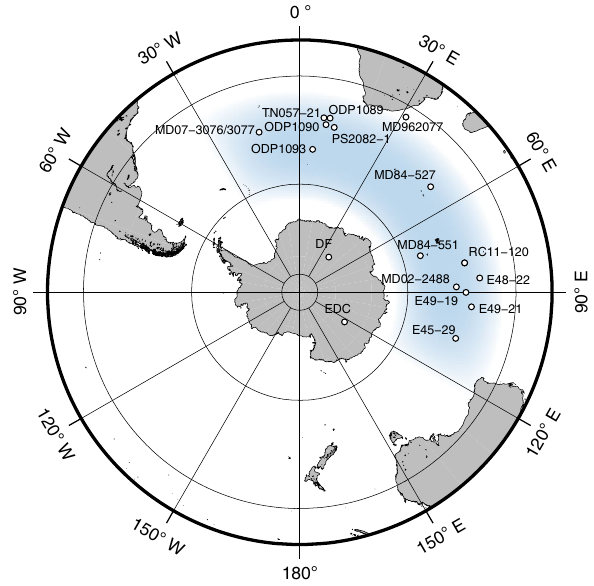
Fig. 1 Locations of ice cores and marine sediment cores. Blue shading indicates the main present-day moisture source of the Dome Fuji site, as determined using back-trajectory calculations 24 – 26 . White dots indicate the locations of ocean sediments used to construct the stacked SST